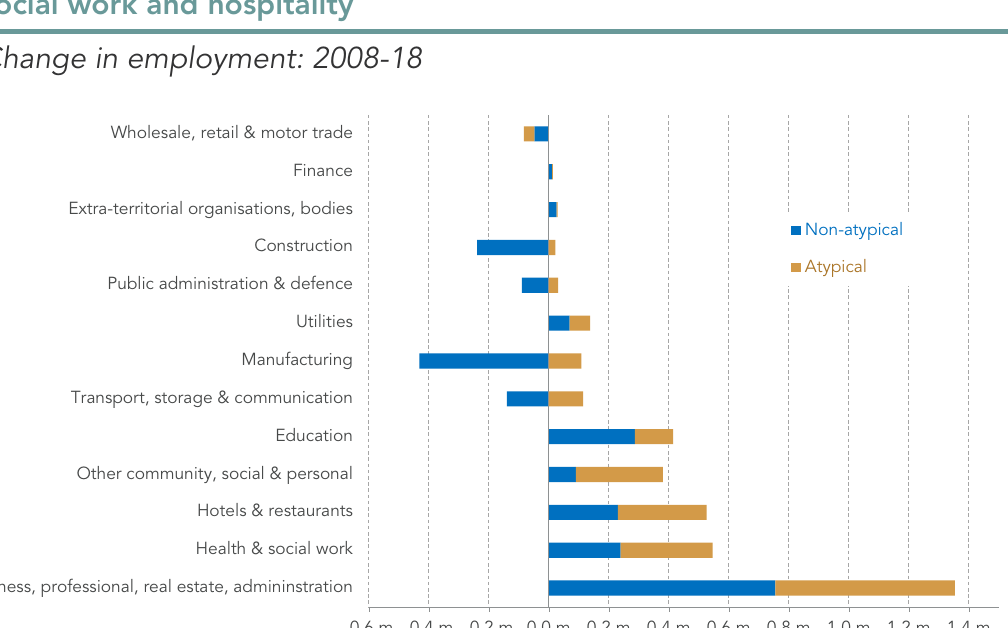
Figure 31: Atypical work has grown strongly in business activities, health and social work and